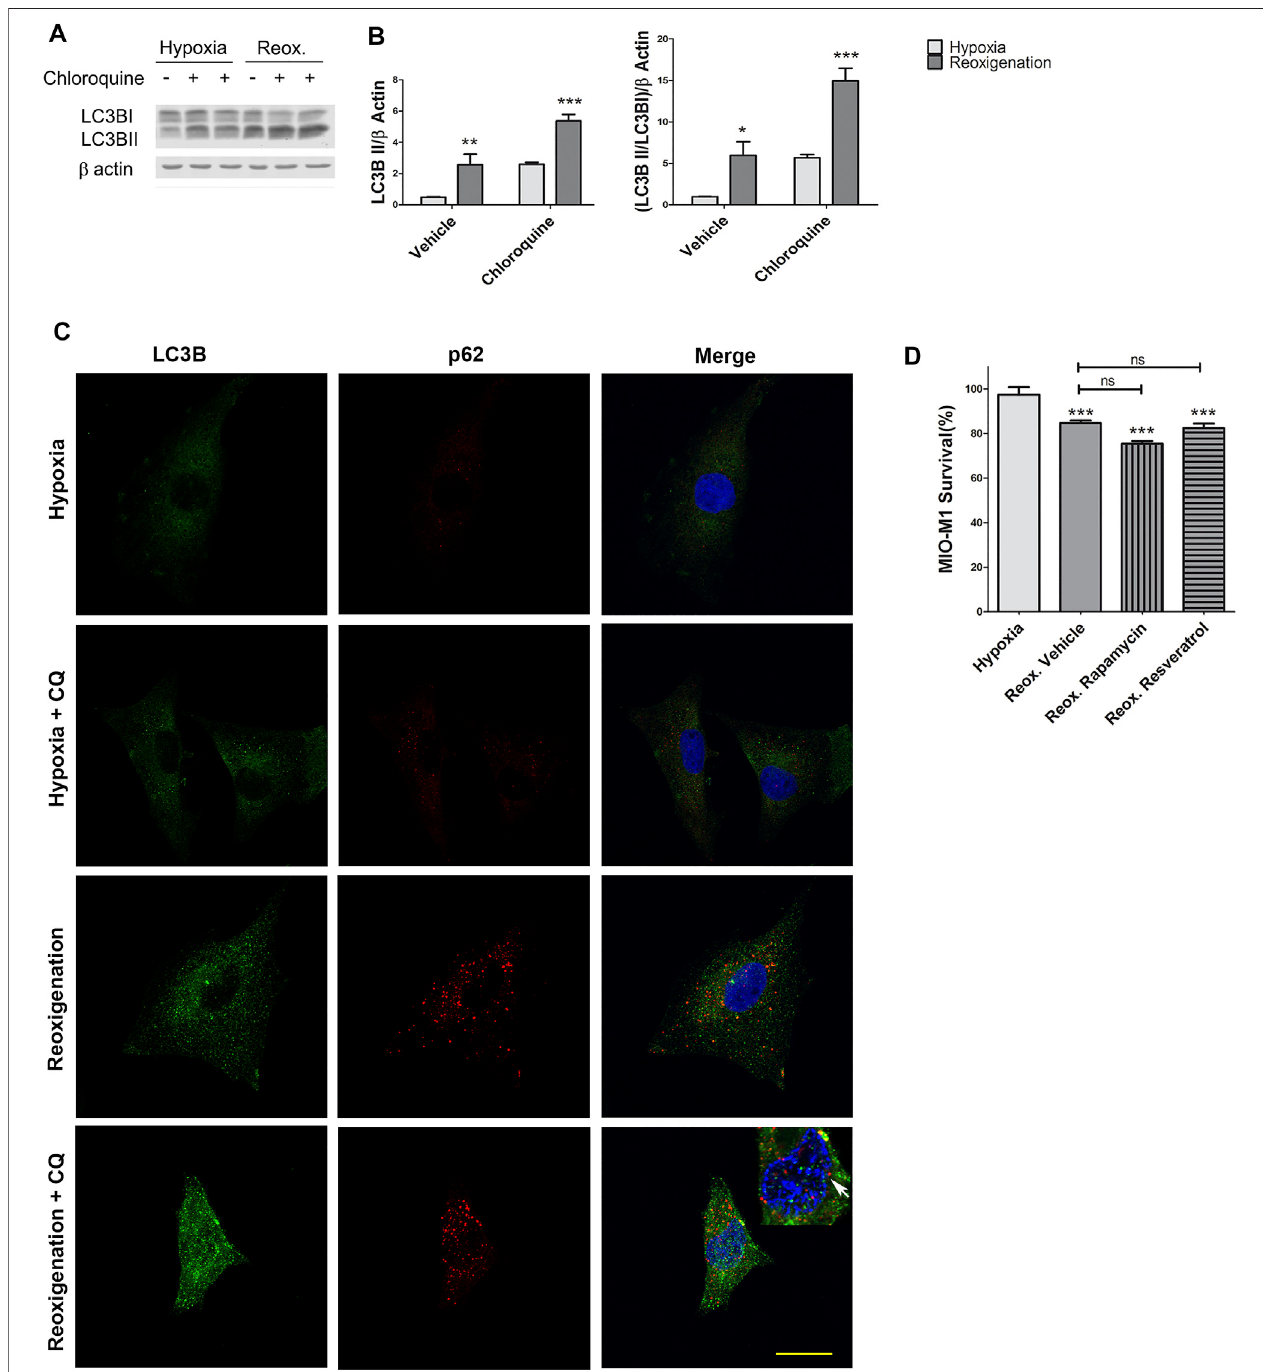
FIGURE3| Reoxygenationincreases LC3BIIandp62 proteinlevels inMIO-M1. (A) RepresentativeWesternblotofautophagymarkerLC3BIIfromcellular lysates of MIO-M1 incubated in hypoxic conditions (1% O 2 ) during 4 h and later returned to normoxia for 1 h (reoxygenation). (B) Protein levels of LC3B II were quanti fi ed by densitometry and normalized to β actin. (C) Representative immuno fl uorescence analysisofLC3B (green) and p62 (red) in MIO-M1 incubated in hypoxic conditions (1% O 2 ) during 4 and 1 h of reoxygenation. Cell nuclei were counterstained with Hoechst 33258 (blue). Images were taken with oil 60X objective in the best confocal resolutioncondition. (D) EvaluationoftheviabilityofMIO-M1cellsinhypoxicconditionsorhypoxia-reoxygenationandincubatedwithvehicle,RapamycinorResveratrol. Data is presented as mean ± SEM. * p < 0.05, ** p < 0.01, *** p < 0.001. Graph shows results of three independent experiments.